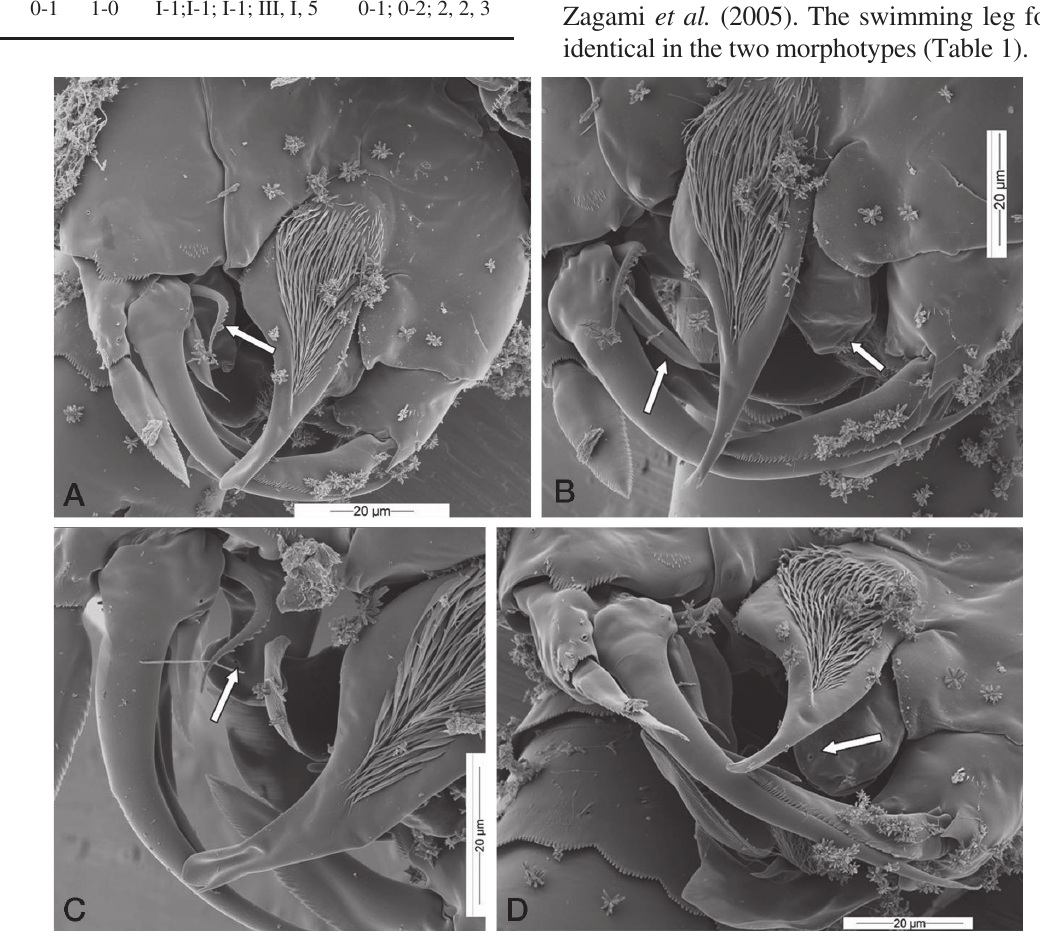
Fig . 6. – scanning electron micrographs of fifth leg pair of male P. xiphophorus from lake faro. a, anterior view showing suture separating coxa and basis on right side and tapering process arising from undivided protopod on left side; B, antero-lateral view showing previously unrecognised lobate endopod (arrowed) on left side; C, antero-lateral view showing ornamentation on left protopodal process and margins of lamellate processes representing distal exopodal segments on left side; D, antero-ventral view showing integumental pore on left endopodal lobe and distal lamellate process of left